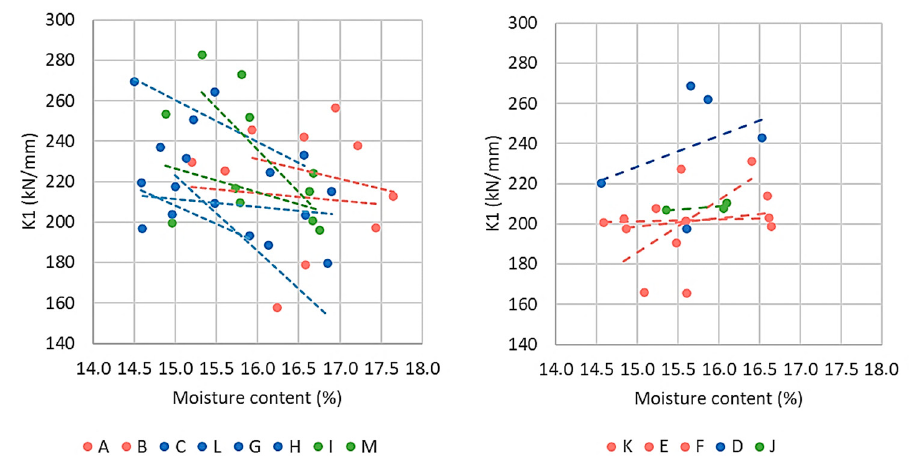
Figure 11. Correlation between stiffness K1 and moisture content of timber of different series. 20 mm notch depth specimens are represented by the red points, 25 mm in green, and 35 mm in blue.